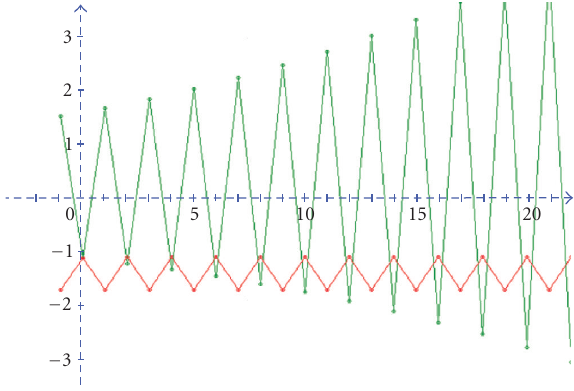
Figure 3.6. Behavior of x n and y n in the point U .